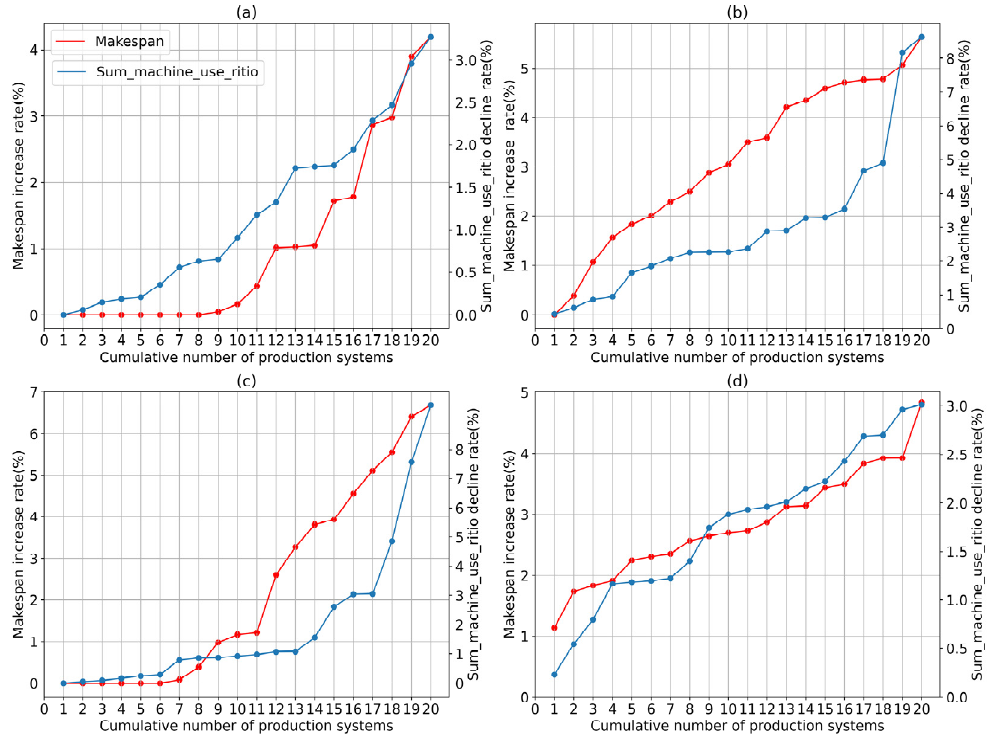
Figure 19. Comparison of the decision-making model and optimal DR combination results (( a ) rep- resents high job heterogeneity and a high manufacturing system load rate, ( b ) shows low job het- erogeneity and a low manufacturing system load rate, ( c ) shows high job heterogeneity and a high manufacturing system load rate, and ( d ) represents high job heterogeneity and a low manufacturing system load rate).